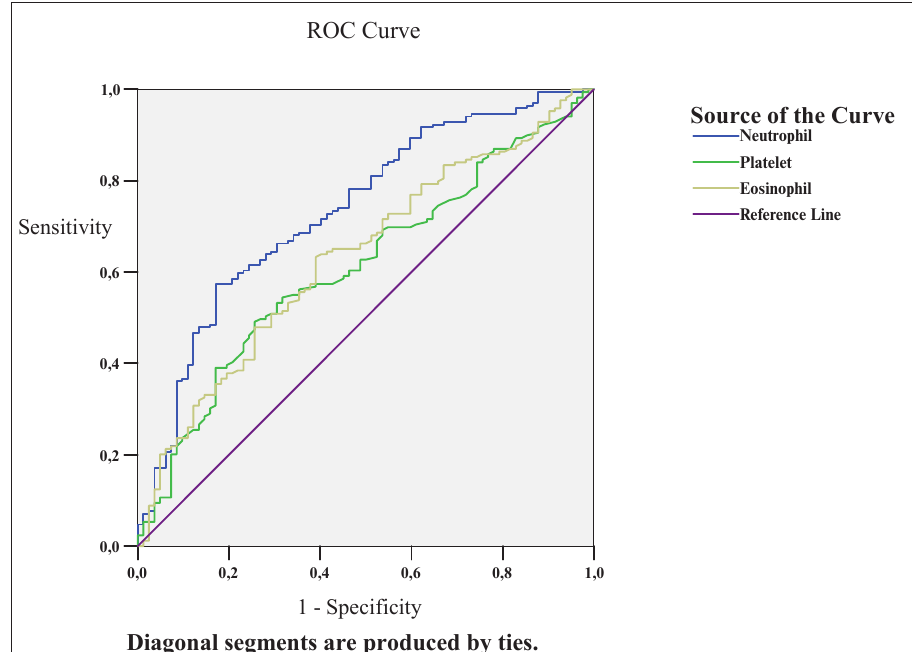
Fig. 1. Receiver-operating characteristic (ROC) curve analysis to determine the best cut-off value of eosinophil count predict thrombus formation in